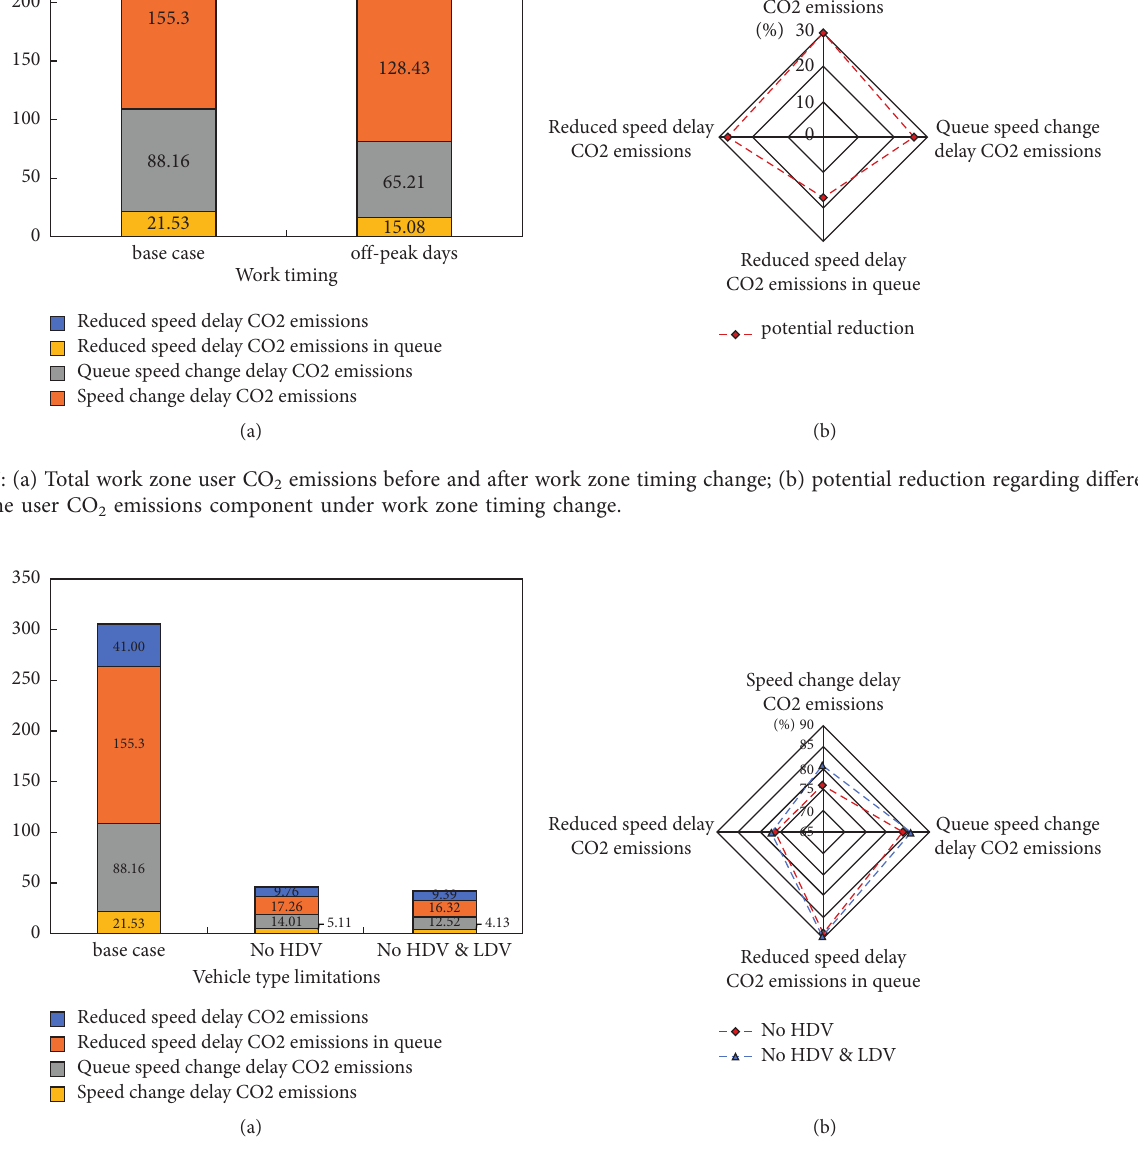
Figure 8: (a) Total work zone user CO 2 emissions; (b) potential reduction regarding different work zone user CO 2 emissions component under vehicle type